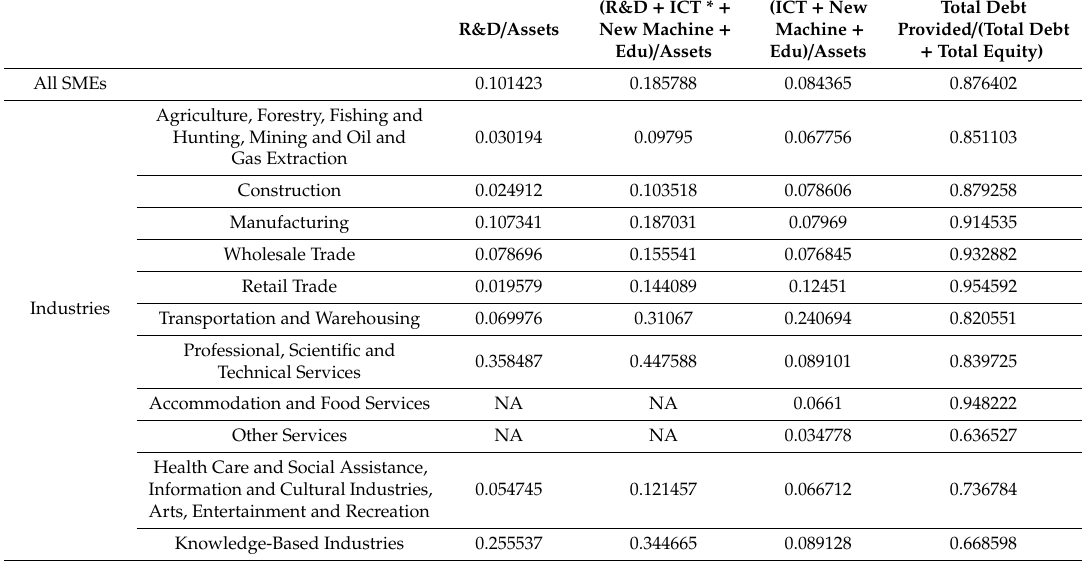
Table 2. Capital structure of SMEs in di ff erent